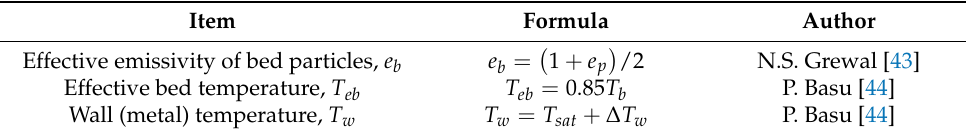
Table 2. Parameters used for the estimation of radiative heat transfer